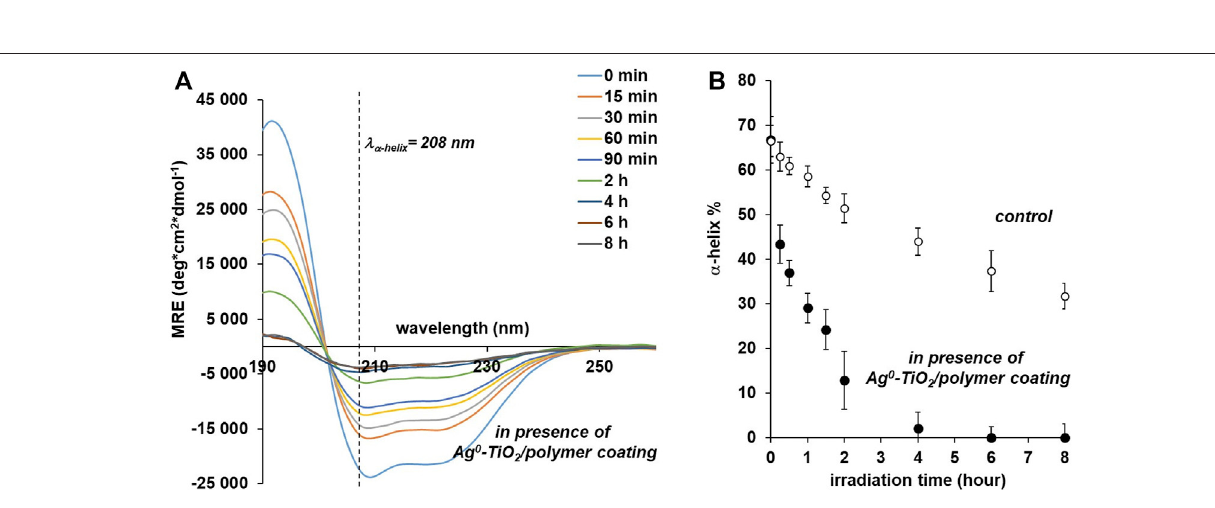
Frontiers in Bioengineering and Biotechnology |